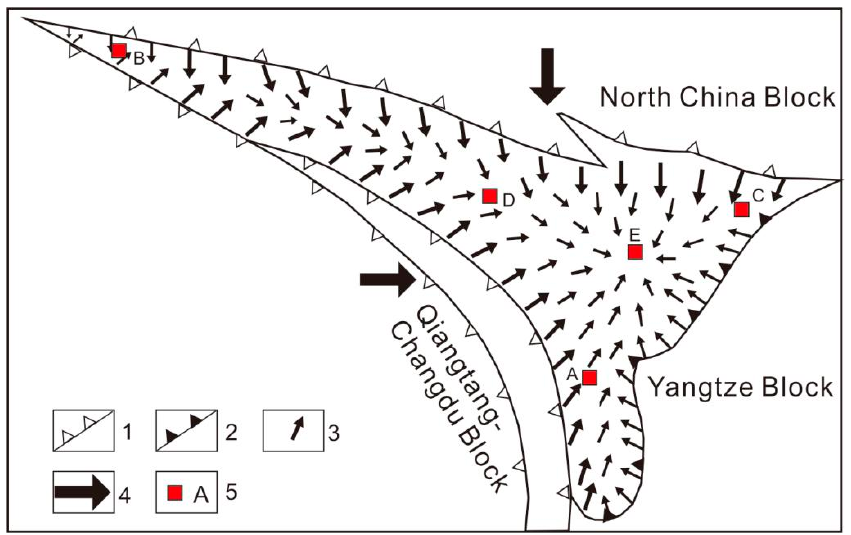
Figure 12. Orogenic process inferred from the ore-forming ages of pegmatite deposits in the Songpan– Ganzê orogenic belt. 1: Abduction zone; 2: Displacement fault; 3: Tectonic stress; 4: Direction of collision and pressure; 5: Pegmatite deposits; A: Jiajika deposit; B: Dahongliutan deposit; C: Xuebaoding deposit; D: Zhawulong deposit; E: Ke’eryin deposit.